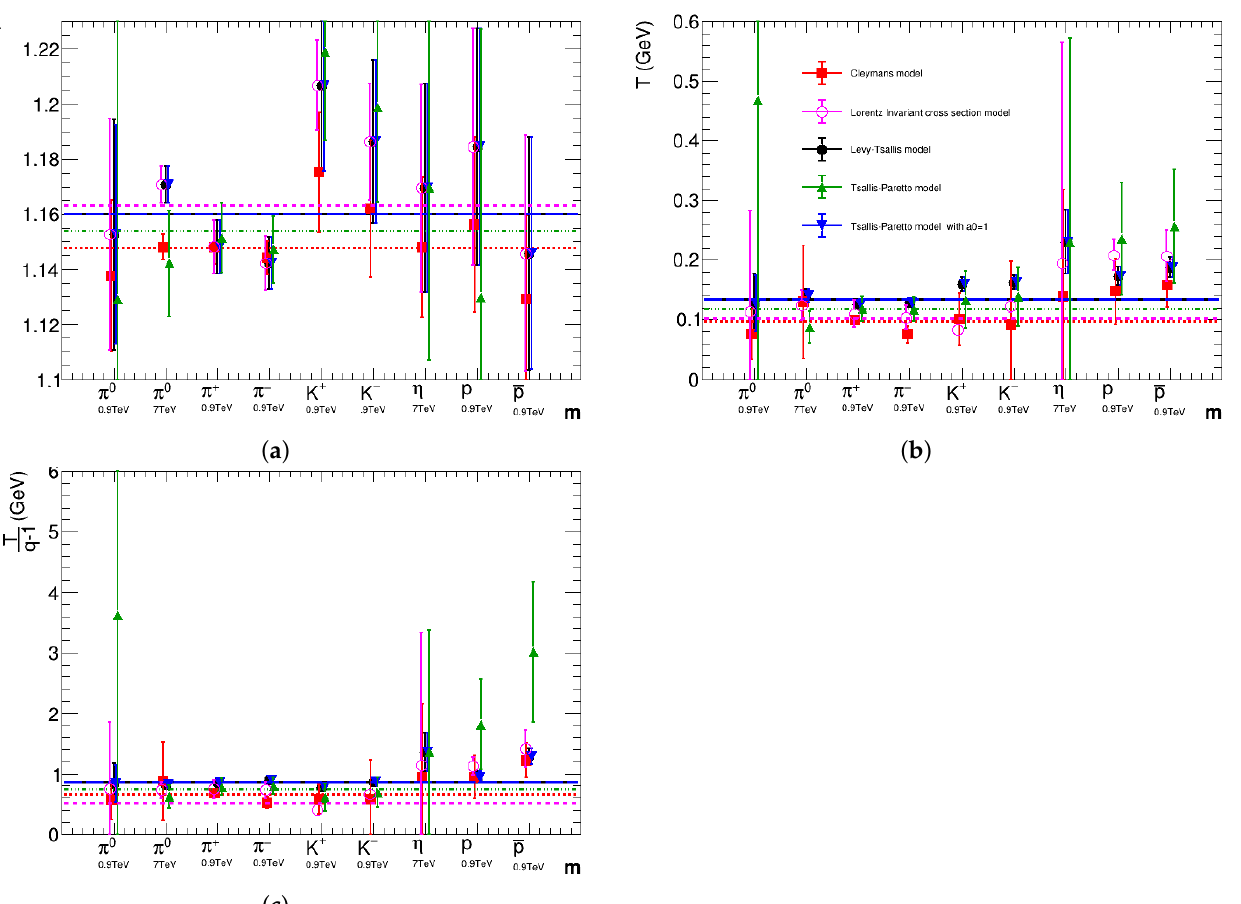
Figure 2. Behavior of the Tsallis exponent, q , temperature, T , and the ratio, T / ( q − 1 ) , as a function of the particle species. extracted from the fits with different formulas. The relation, n = ( q − 1 ) − 1 , used where necessary (see the text for details). ( a ) Tsallis exponent, q ( b ) temperature, T ( c ) the ratio, T / ( q − 1 )